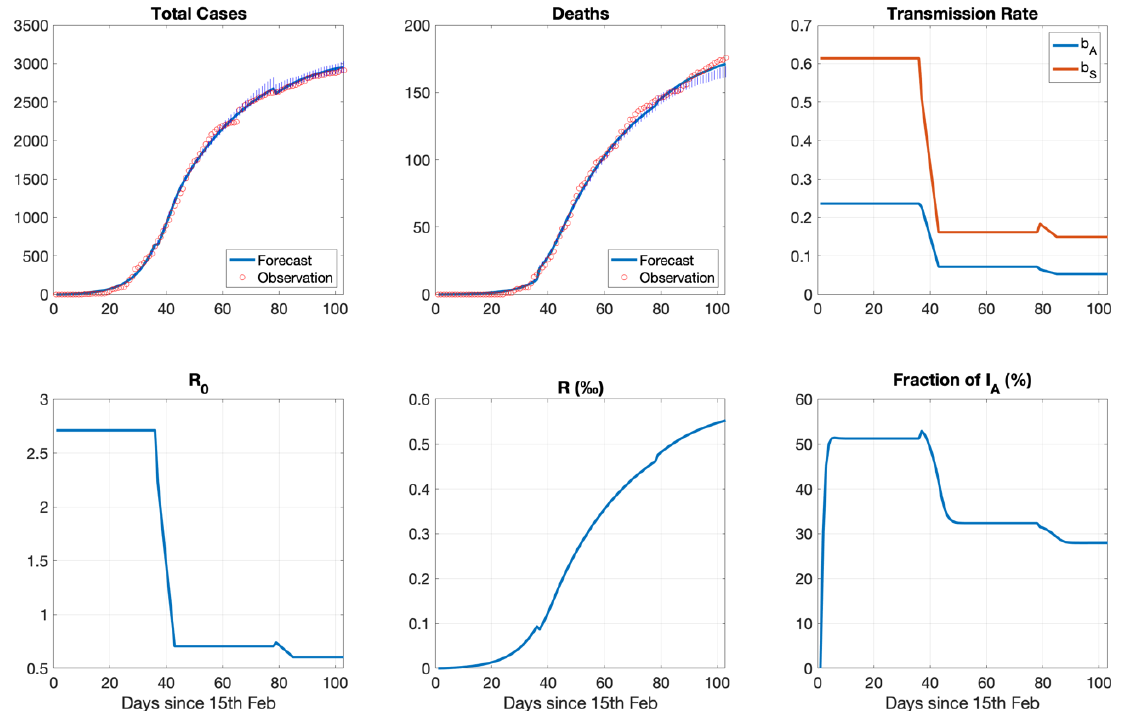
Figure 4. [Top row] Dynamic evolution of the ensemble of simulations (boxplot (light blue) with interquartile range (deep blue part), which set the uncertainty limits of the forecast, together with the optimal simulation (solid line) and the observations (red circles). Left panel shows the symptomatic infected persons ( I S ), middle panel the deaths, right panel the R 0 . [Bottom row] Optimum transmission rates identified from the MC experiments (left panel). Dynamic evolution of the corresponding fraction of the population who recovered (middle panel). Fraction of the asymptomatic infected persons ( I A ) among all infected cases (right panel). See text for explanation.